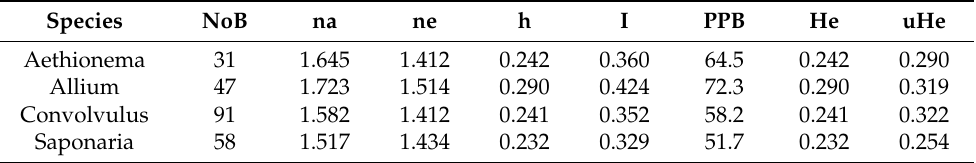
Table 3. Genetic diversity averaged for all the ISSR markers used per species. NoB: number of bands. na: number of alleles. ne: effective number of alleles. h: Nei’s gene diversity. I: Shannon’s